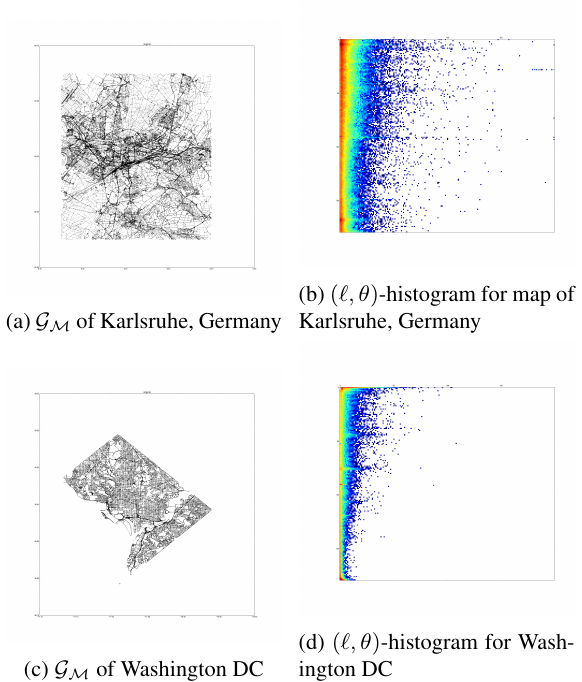
Figure 9: Analysis of G M of urban and semi-urban cities of Washington DC and Karlsruhe, Germany. The graphs shows the ( (cid:96), θ ) -histogram of the length (cid:96) and orientations θ of the edges of G M (columns correspond to edge lengths (cid:96) and rows correspond to edge orientations θ ). The lattice structured urban and spaghetti structured semi-urban graphs show different histograms reflect- ing the inherent difference in these two types of